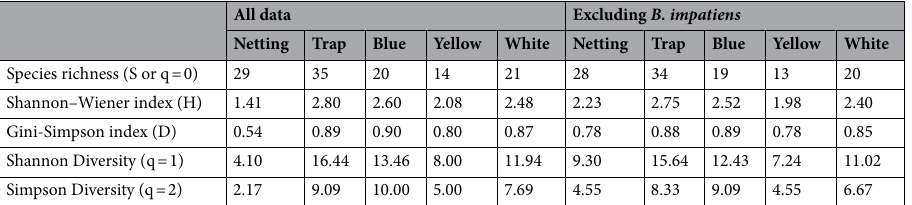
Table 1. Overall diversity measures for the two survey methods and the three pan trap colors when B. impatiens is included (all data) or excluded from the